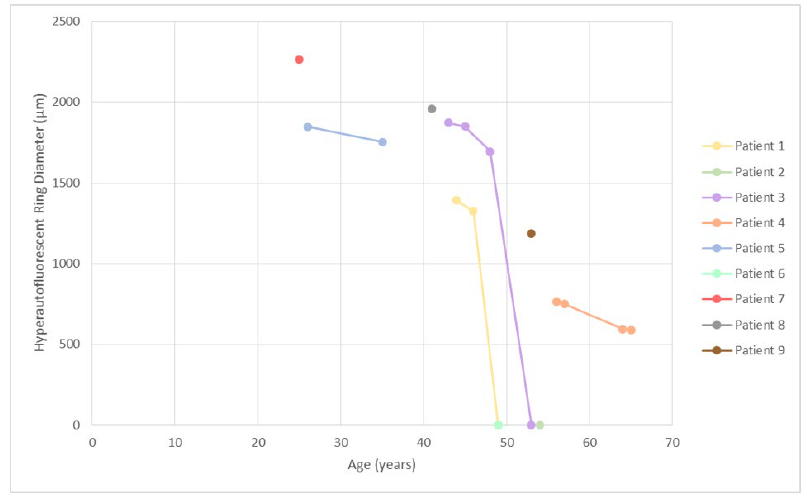
Figure 5. Hyperautofluorescent ring diameter in association with age. Patients 2 and 3 had hyper- autofluorescent patches and/or atrophy; therefore their diameters are marked as zero. Note the trend of progression from ring to patch/atrophy around the age of 50, which corresponds to the sharp decrease in visual acuity (Figures 1 and 4) .